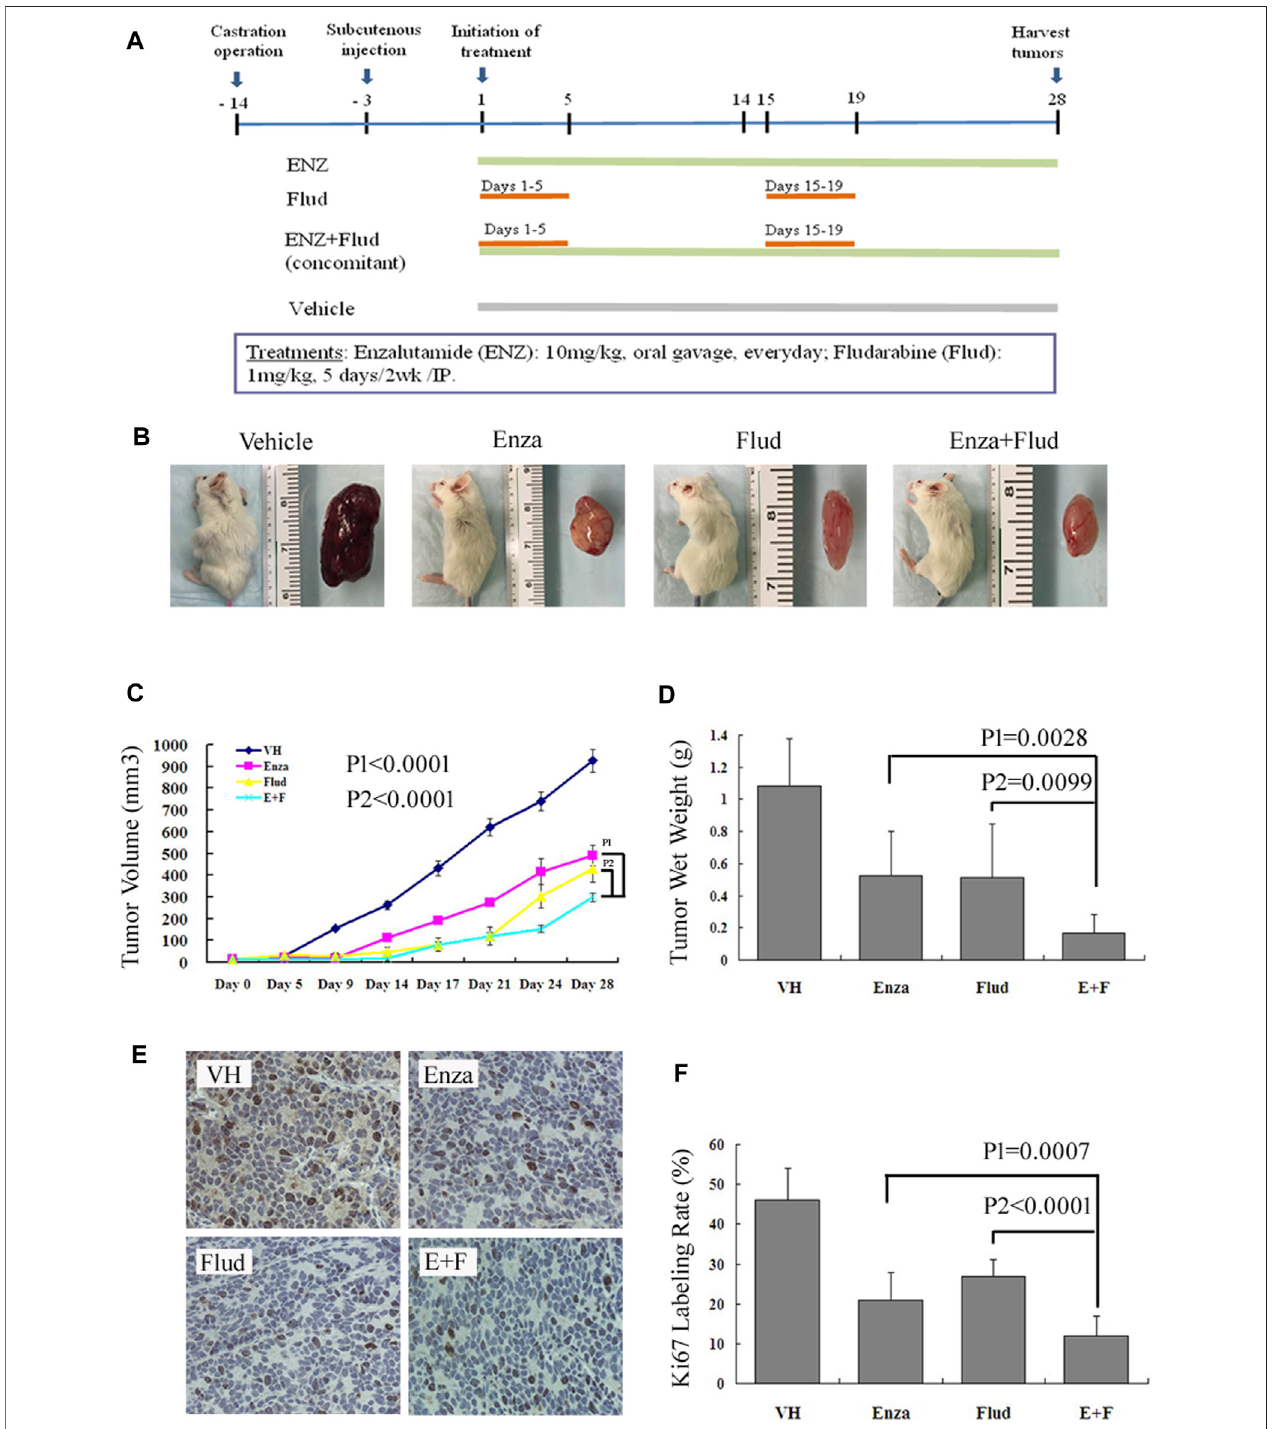
FIGURE 5 | ENZ + FLUD strategy synergistically inhibited the growth of CRPC xenografts. (A) Drug protocol of each treatment group. (B) Representative C4-2B subcutaneoustumorofeachtreatmentgroup. (C) Tumorvolumemeasurementsusingcalipersevery3 – 5 days. (D) Wettumorweightattheendof28 daysoftreatment. (E) Immunohistochemistry of Ki67 in each treatment group. (F) Ratio of Ki67-positive cells in each treatment group.